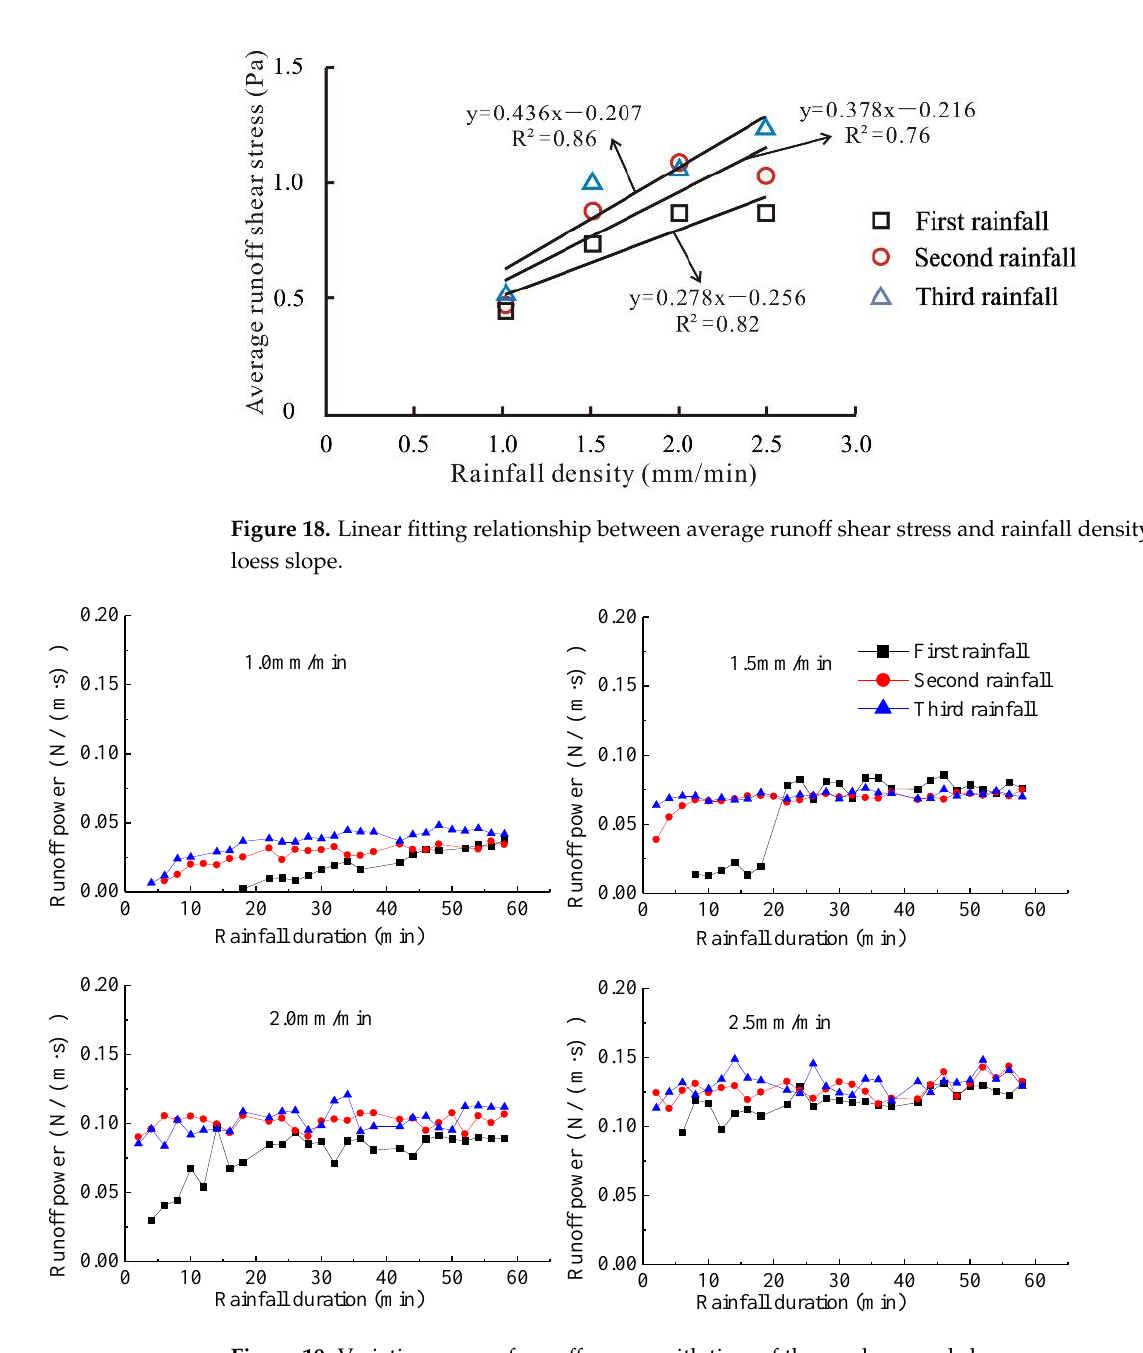
Figure 19. Variation curve of runoff power with time of the sand-covered slope. Table 6. Average downslope runoff power with different rainfall density and